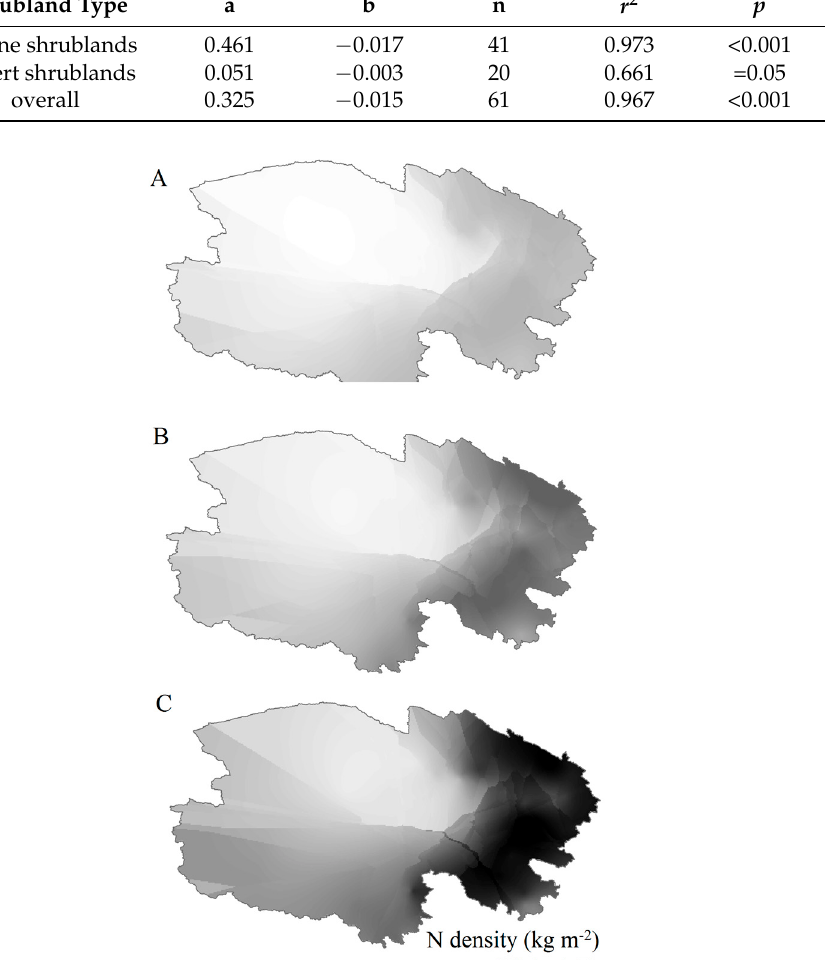
Figure 3. Spatial distributions of soil N densities at different depths ( A ) 0–30 cm; ( B ) 0–50 cm; ( C ) 0–100 cm across the Northeast Tibetan Plateau.